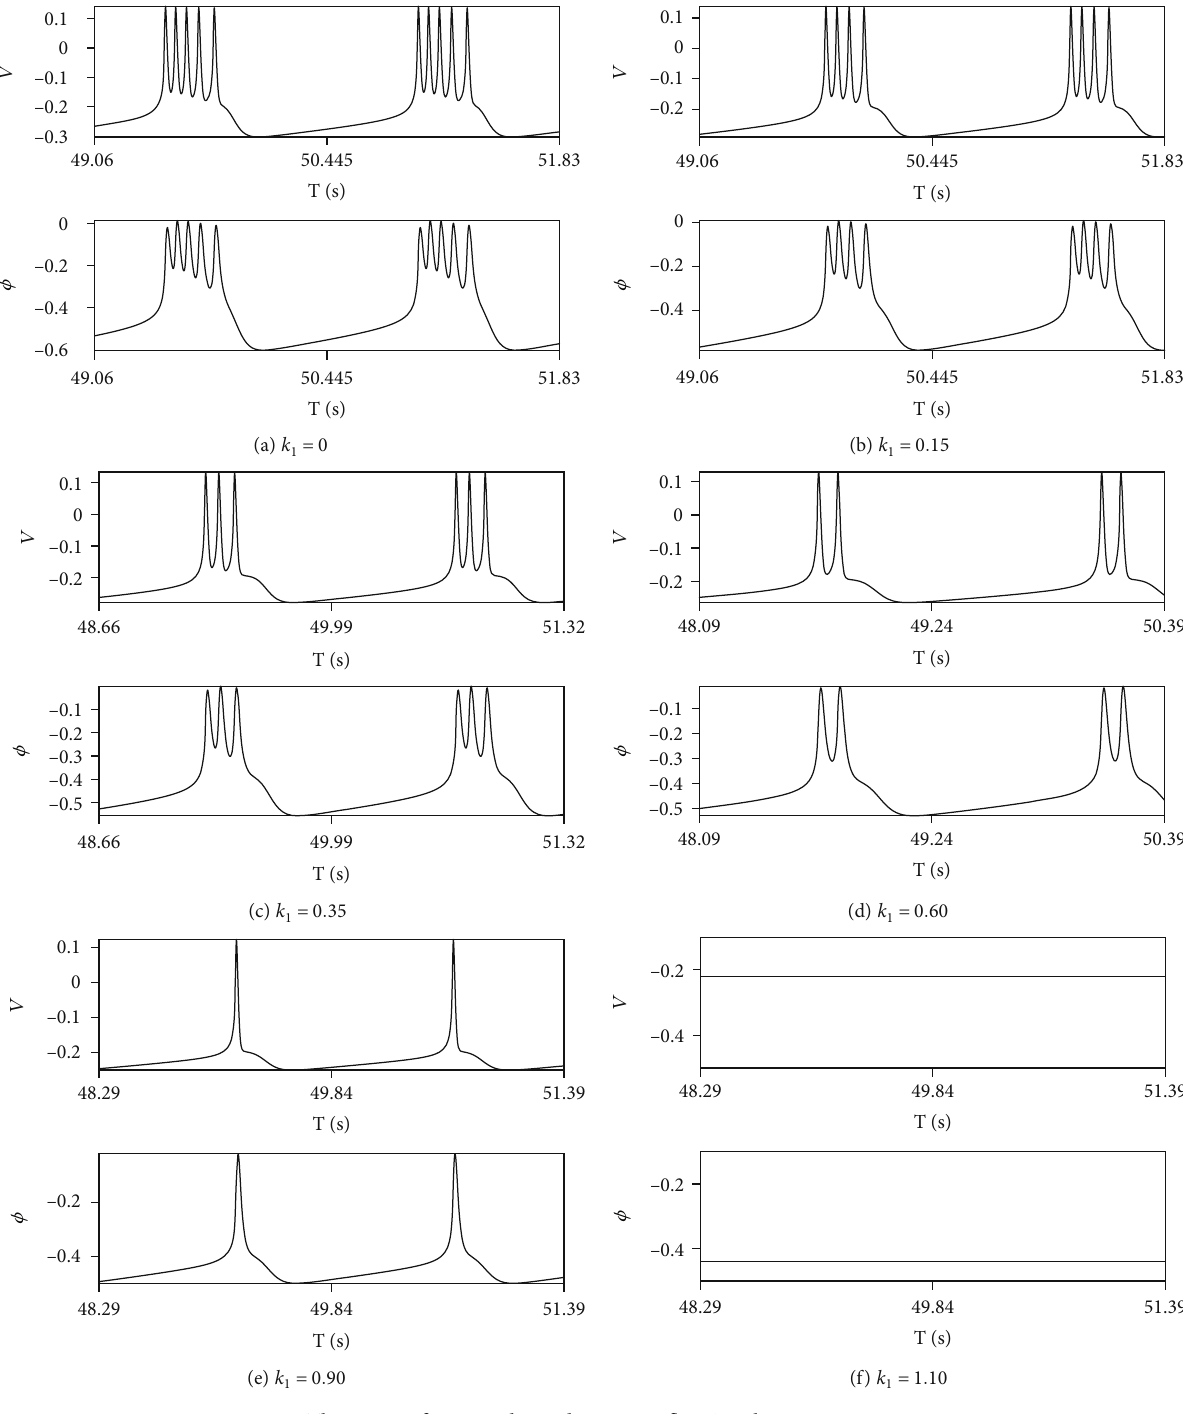
Figure 6). Number of spikes during one period decreases leading that period-5, period-4, period-3, period-2, period- 1 bursting, and resting state are displayed in turn.